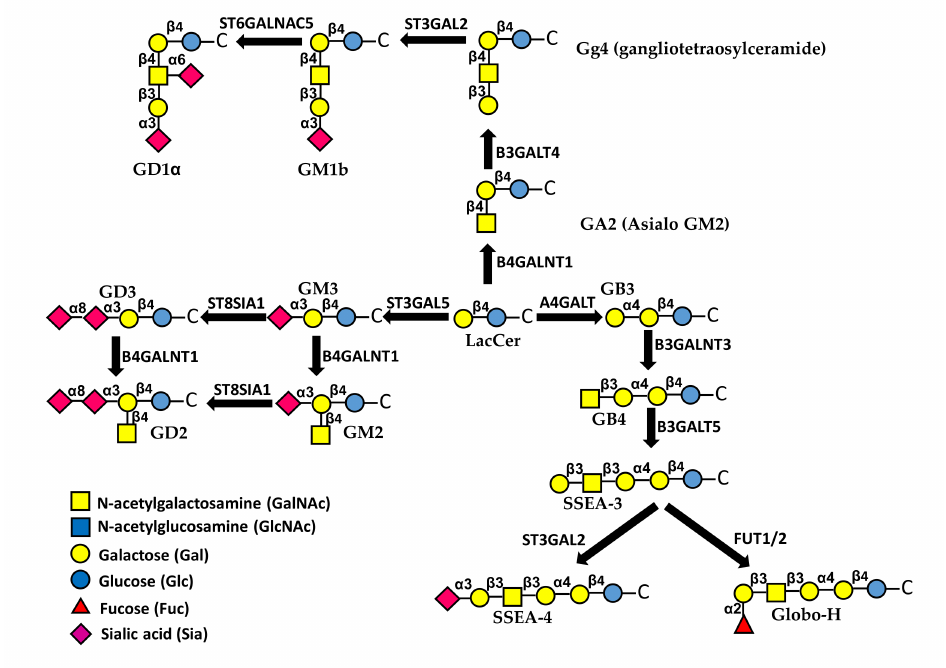
Figure 3. Biosynthesis and structure of major glycolipids. The first sugar attached to ceramide (C) is always Glc, followed by a β 1,4-linked Gal. This basic structure can be elongated through different pathways. Sialylated glycolipids are referred to as